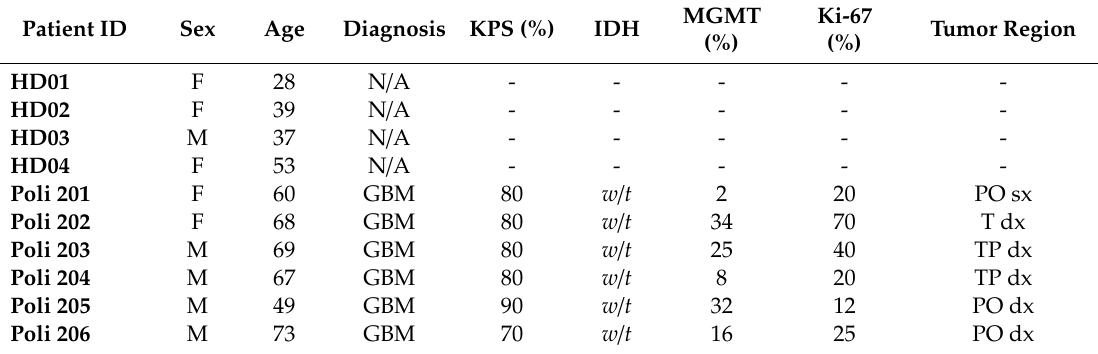
Table 1. Demographic, clinical, and molecular parameters of the patient